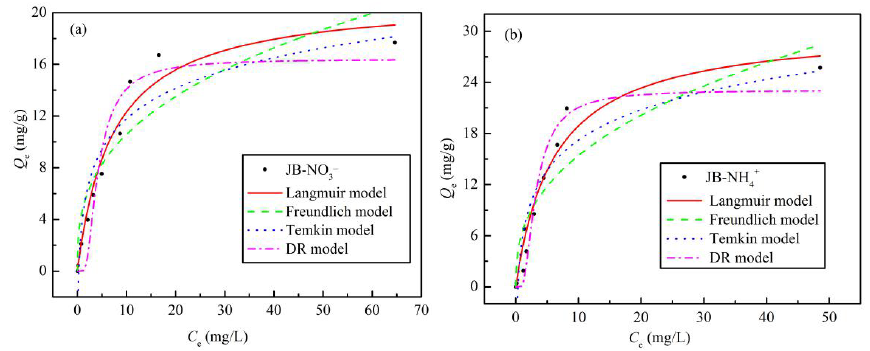
Figure 9. Isotherms adsorption models fitting curves of JB. ( a ) for NO 3 − , ( b ) for NH 4 + . Table 4. Isotherm model parameters of NO 3 − and NH 4+ by JB